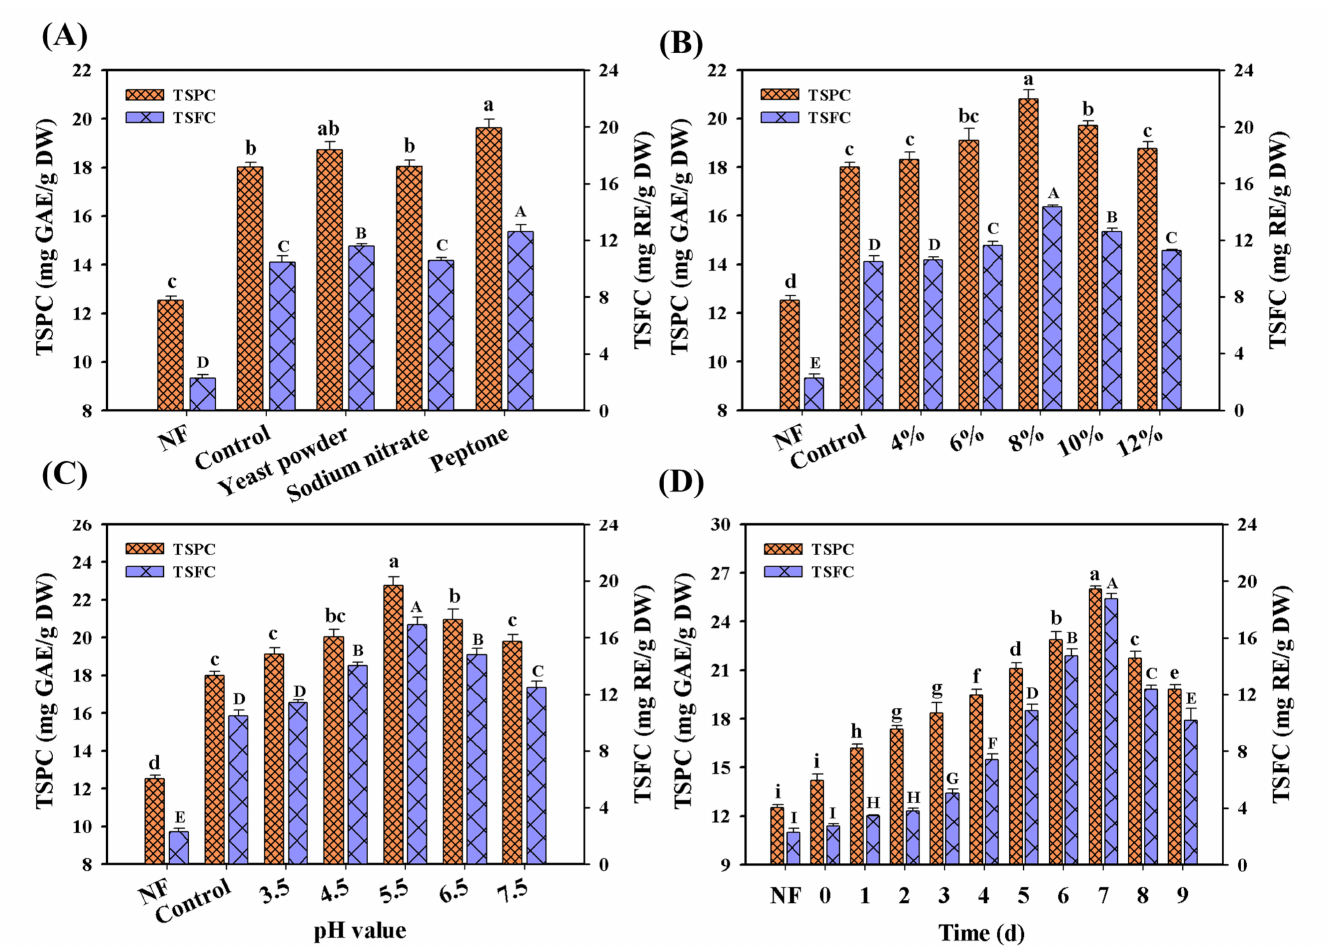
Figure 2. The optimization of fermentation parameters in LSF. ( A ) Nitrogen source, ( B ) inoculation level, ( C ) the initial pH value, ( D ) the combined optimal conditions. NF represents non-fermented Chinese jujube sample. Different superscripts (abcdefghi/ABCDEFGHI) indicated significant dif- ferences between samples at the different fermented conditions ( p < 0.05). NF represented the unfermented